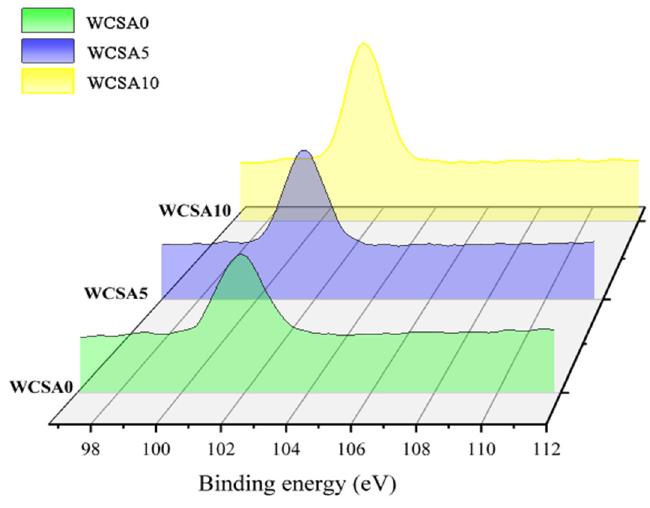
Figure 9. Si2p spectra of three groups of WCS.